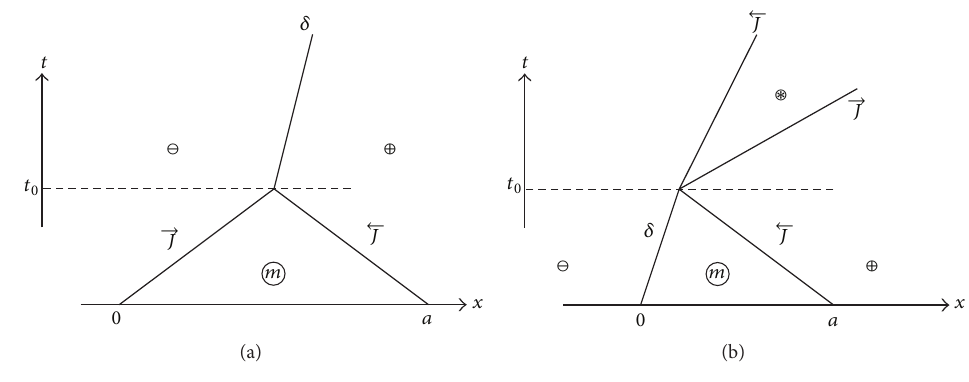
Figure 6: Two kinds of interactions of elementary